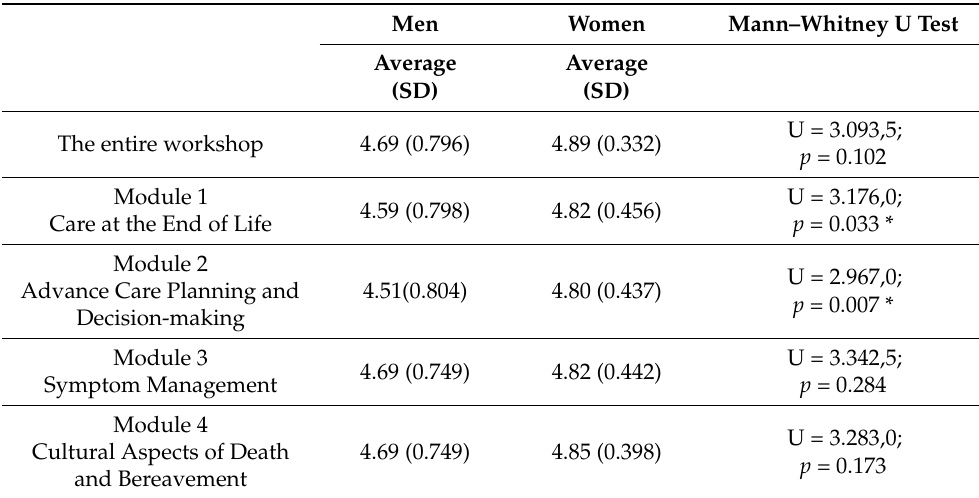
Table 4. Participant ratings (the entire course and individual modules) by sex (Mann–Whitney U test).